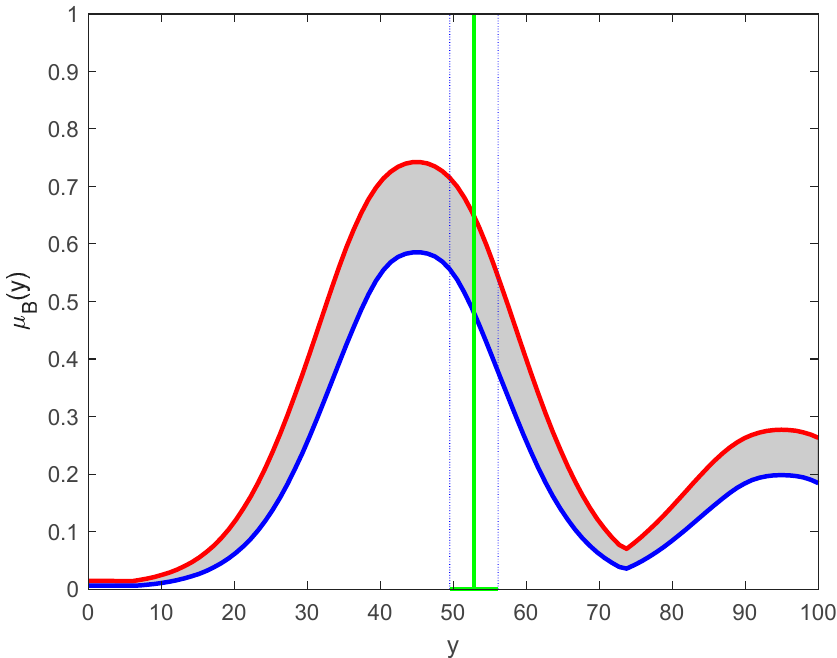
Figure 5. Illustration of the type reduction process for a value of x = 6.